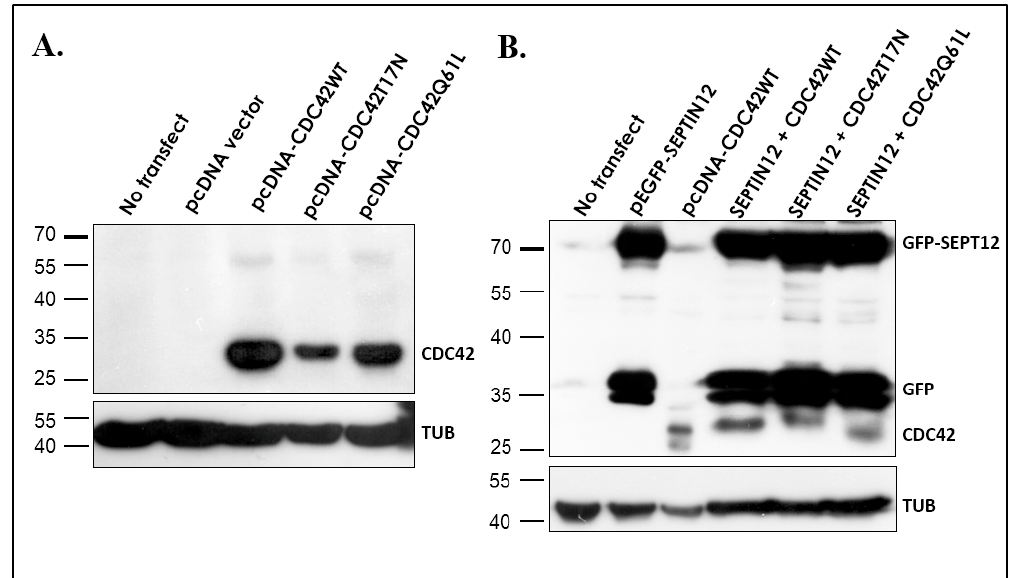
Figure 4. CDC42 and SEPT12 constructs expressed in 293T cells. ( A ) The lysates from cells transfected with mock (no transfect; lane 1), empty pcDNA vector (pcDNA vector; lane 2), pcDNA-Cdc42 wild-type vector (pcDNA-Cdc42WT; lane 3), pcDNA-Cdc42T17N vector (lane 4), or pcDNA-Cdc42Q61L vector (lane 5) were blotted with anti-CDC42 antibody (upper panel), and anti- α -tubulin antibody (bottom panel), as loading controls. ( B ) Lysates from cells transfected with mock (no transfect; lane 1), pEGFP-Sept12 vector (lane 2), pcDNA-Cdc42 wild-type vector (pcDNA-Cdc42WT; lane 3), pEGFP-Septin12 with pcDNA-CDC42WT vectors (SEPTIN12 + CDC42; lane 4), pEGFP-Septin12 with pcDNA-CDC42T17N vectors (SEPTIN12 + CDC42T17N; lane 5), or pEGFP-Septin12 with pcDNA-CDC42Q61L vectors (SEPTIN12 + CDC42Q61L; lane 6). Membranes were blotted with anti-EGFP antibody (GFP-SEPT12 and GFP; upper panel), anti-CDC42 antibody (CDC42; upper panel), and anti- α -tubulin antibody (bottom panel) as loading controls.